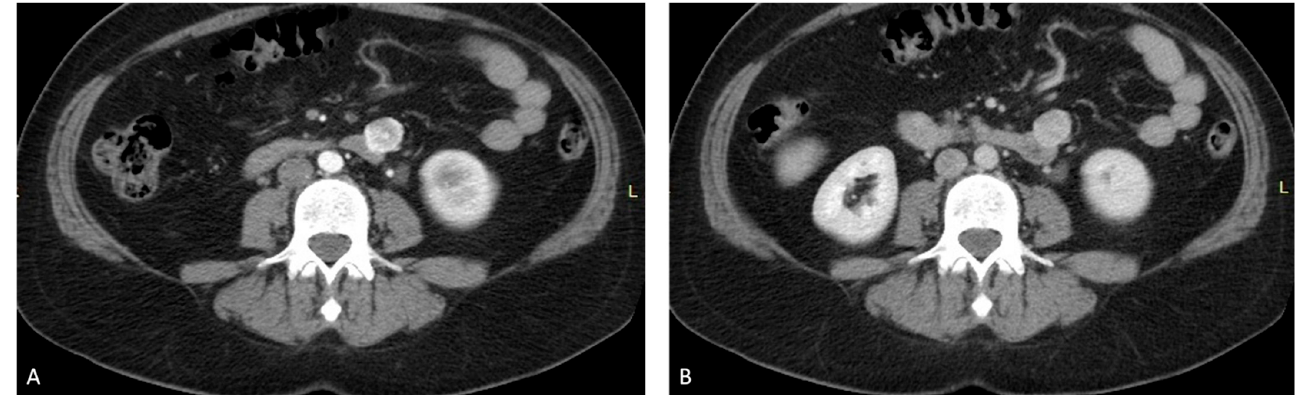
Figure 2. Abdominal CT with contrast: ( A ) arterial time; and ( B ) venous time. Welldefined tumor with necrotic core.